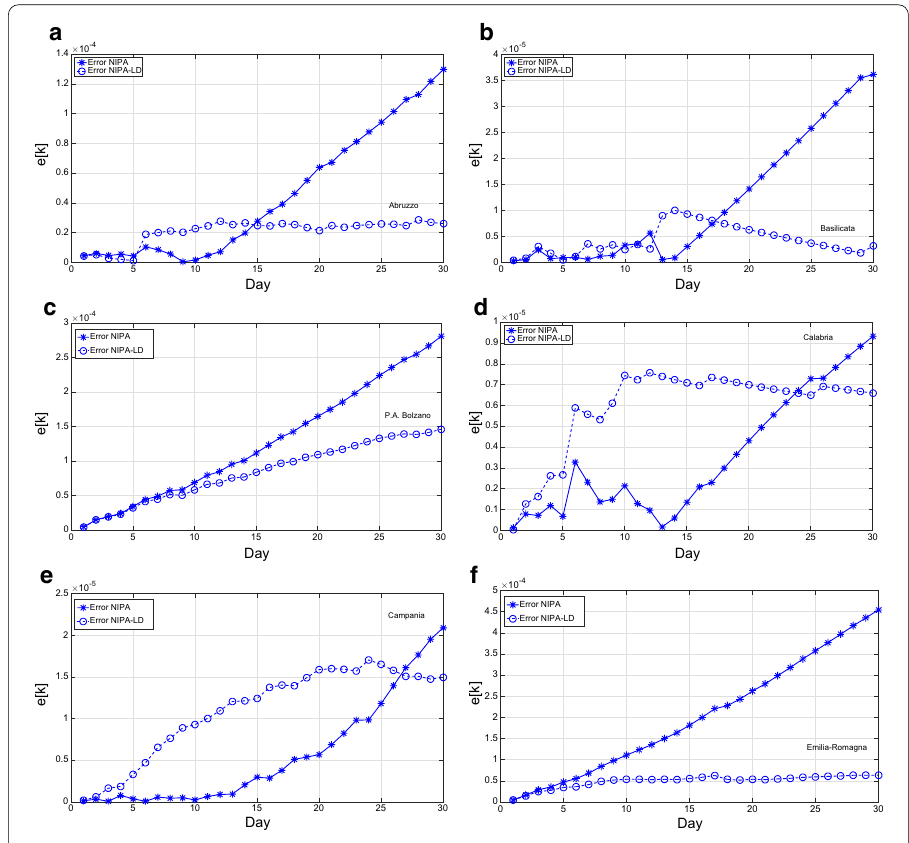
Fig. 9 Mean relative prediction error for the period from May 10th to June 9th: 12